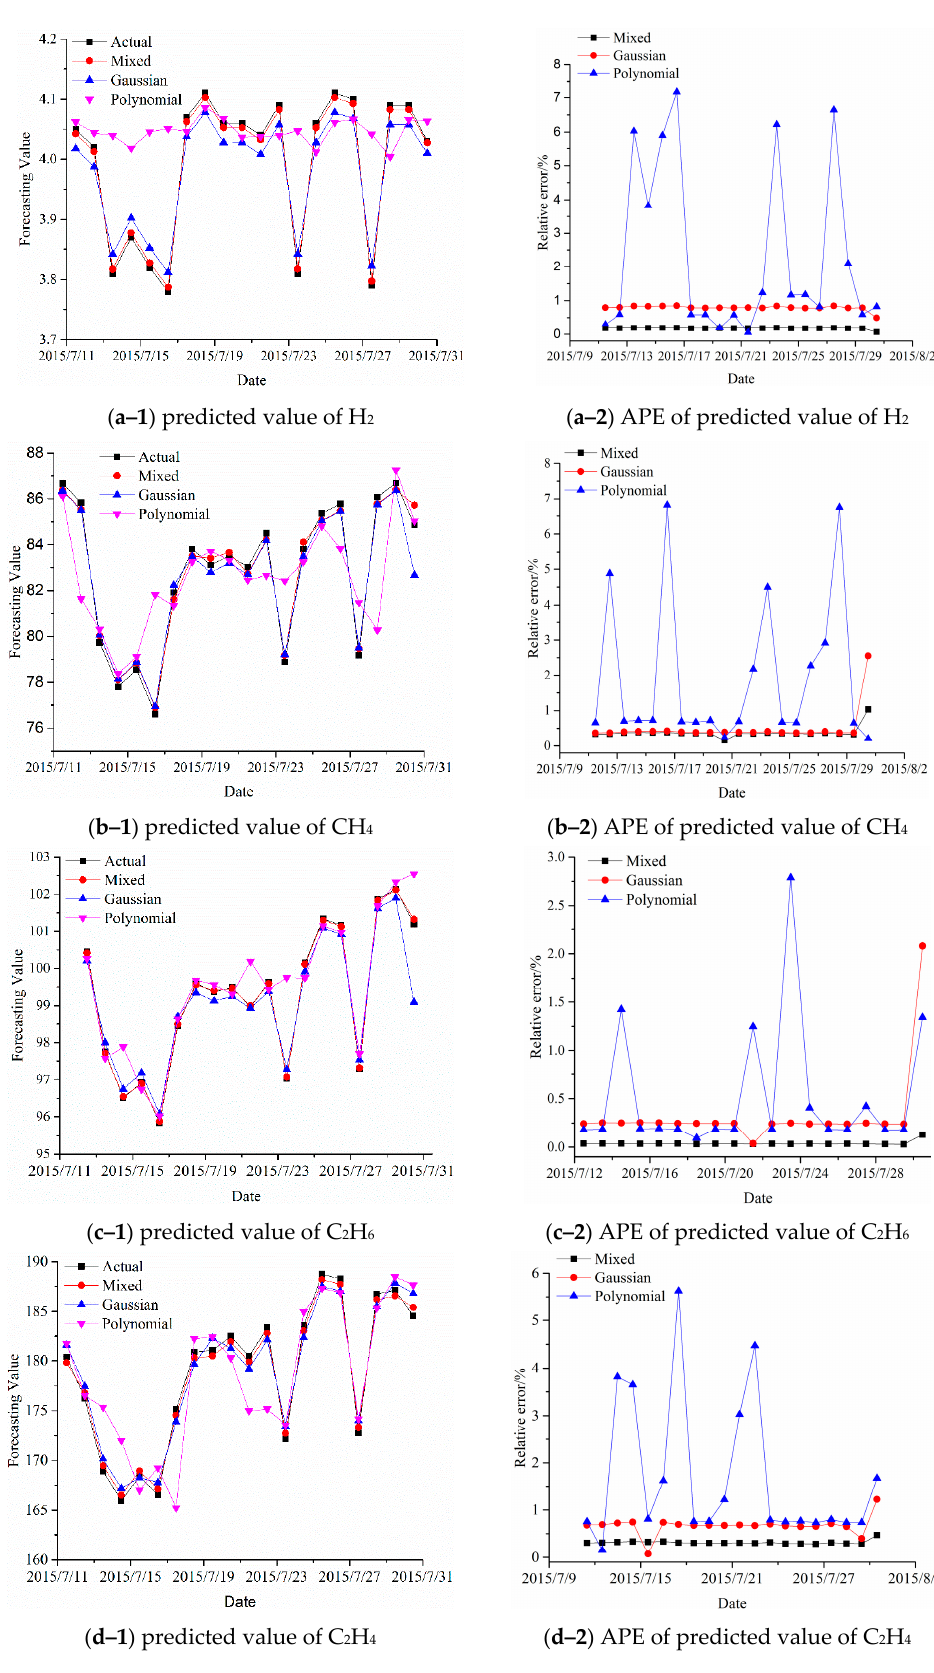
Figure 6. Forecasting value and APE of SVR model with different kernels (Case 1).